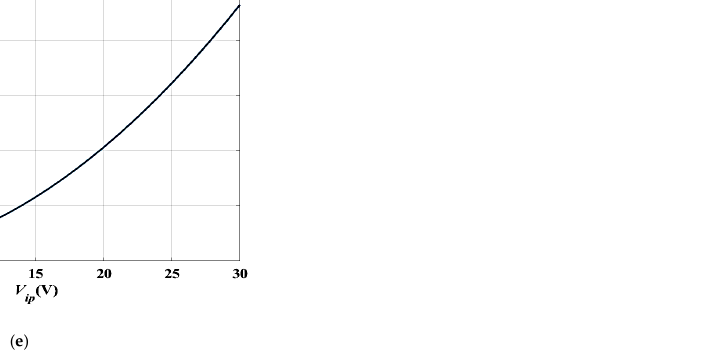
Figure 9. ( a ) Electric potential distribution, ( b ) electric field distribution, ( c ) converter displacement due to the input vibration signal, ( d ), stress analysis, and ( e ) P out at different values of V ip .